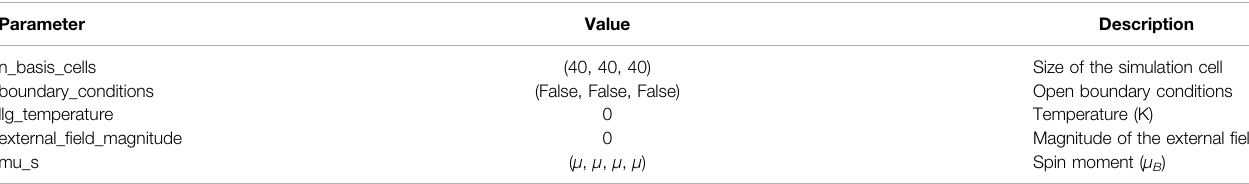
TABLE3| ParametersfortheLLGcalculationsfor γ – Fe.Notethatthesimulation cellconsistsof40×40×40×4=256,000atomsduetothechoiceoftheconventionalunit cell with four atoms. The spin moment μ is extracted from the DFT calculation at the respective lattice constant and open boundary conditions are chosen. Parameters not listed here are set to the same value as in Table 1 .